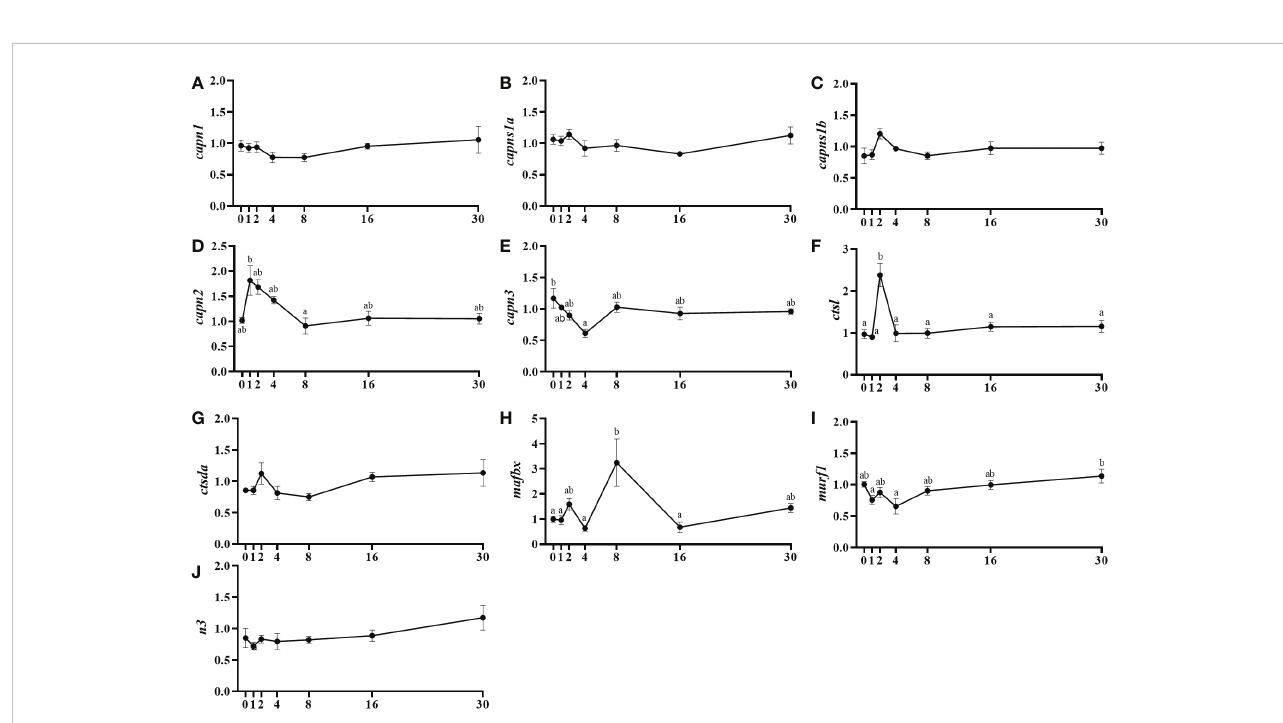
FIGURE 3 Relative gene expression of the proteolytic systems' markers, capn1 (A) , capns1a (B) , capns1b (C) , capn2 (D) , capn3 (E) , ctsl (F) , ctsda (G) , mafbx (H) , murf1 (I) , and n3 (J) in injured epaxial muscle of fi sh. Data are shown as means ± SEM, n=10. Statistical analysis was assessed by one-way ANOVA. Different letters indicate signi fi cant differences of factor time (days post-injury) (Tukey ’ s HSD or Games-Howell post-hoc test, p <